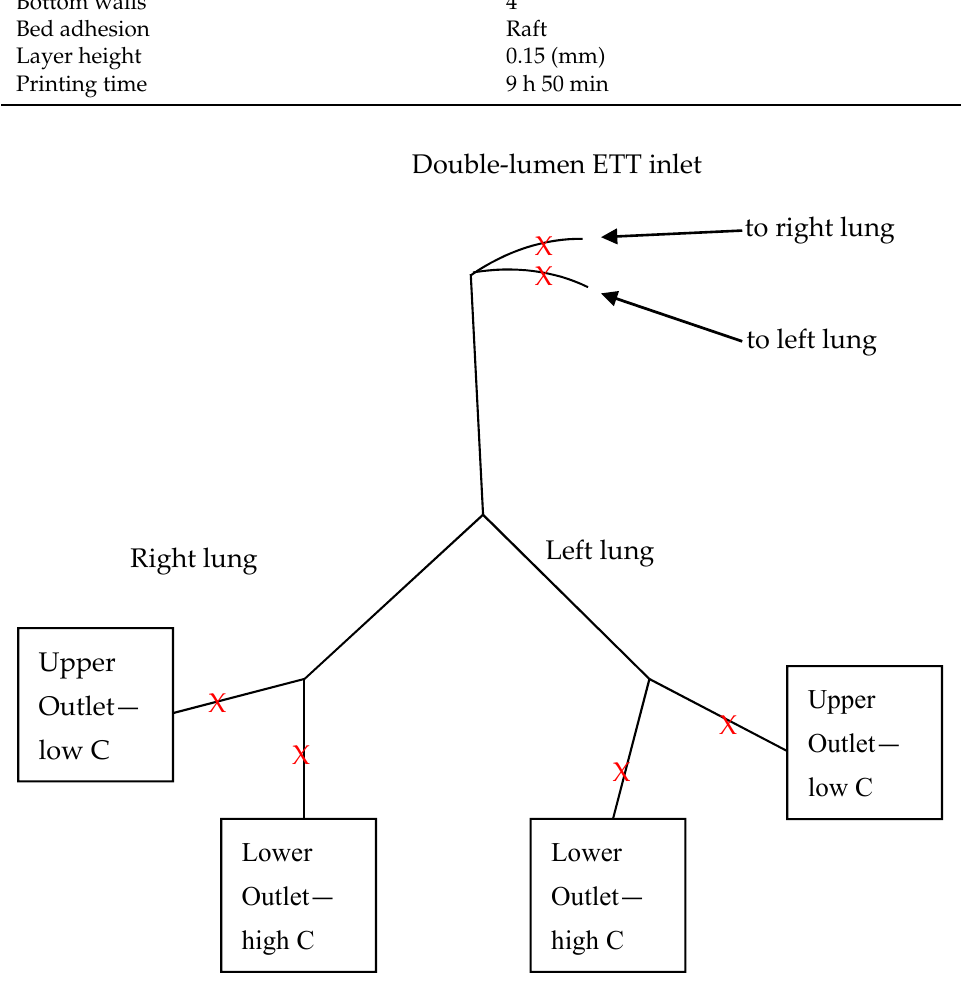
Figure 2. Scheme of the model respiratory system used in the study: C—compliance, ETT—endotracheal tube, Lower Outlet—anesthetic breathing bag, Upper Outlet—Siemens test lung, X—measurement